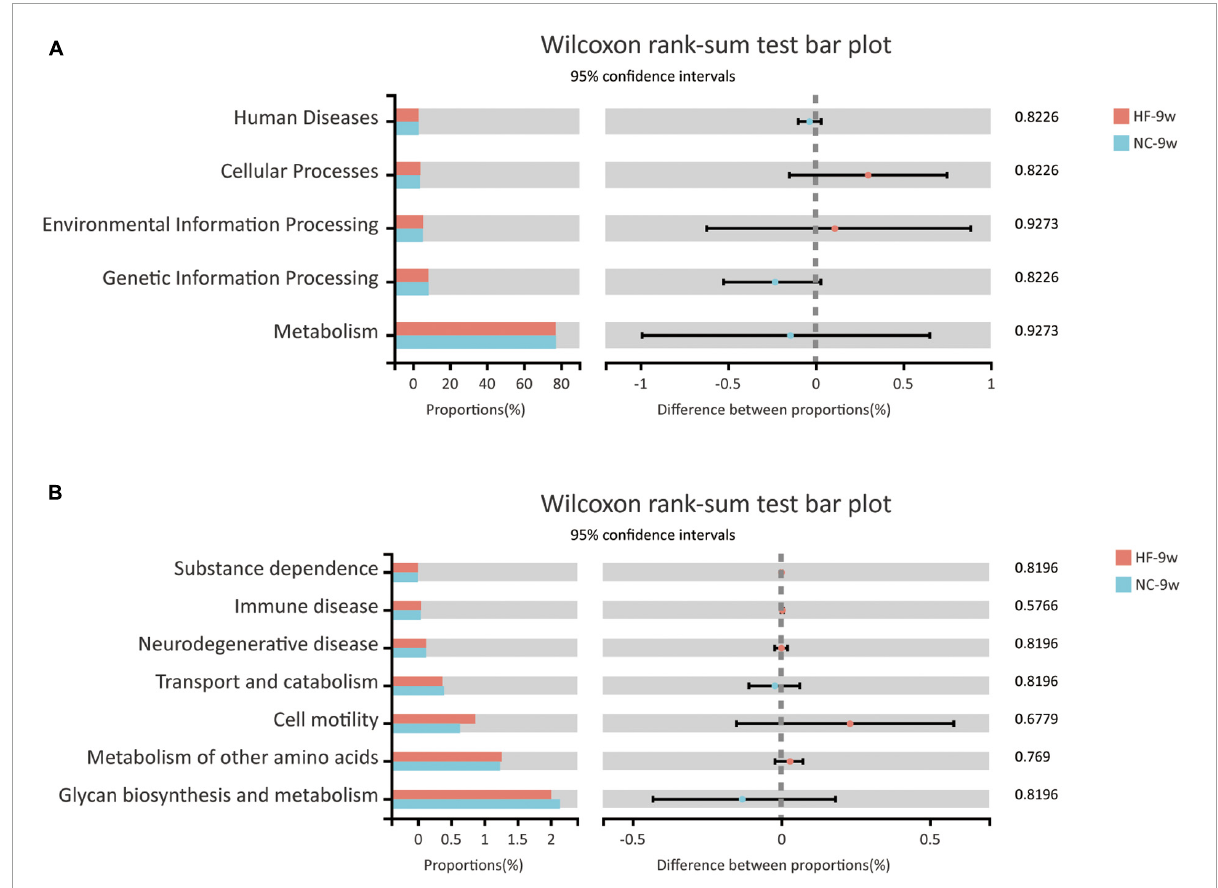
FIGURE9 Functional predictions of bacterial communities by the KEGG pathway database in offspring at 9 weeks of age. (A) KEGG pathway level 1. (B) KEGG pathway level 2 (NC-9w, n = 6; HF-9w, n = 5). NC, normal chow diet; HF, high-fat